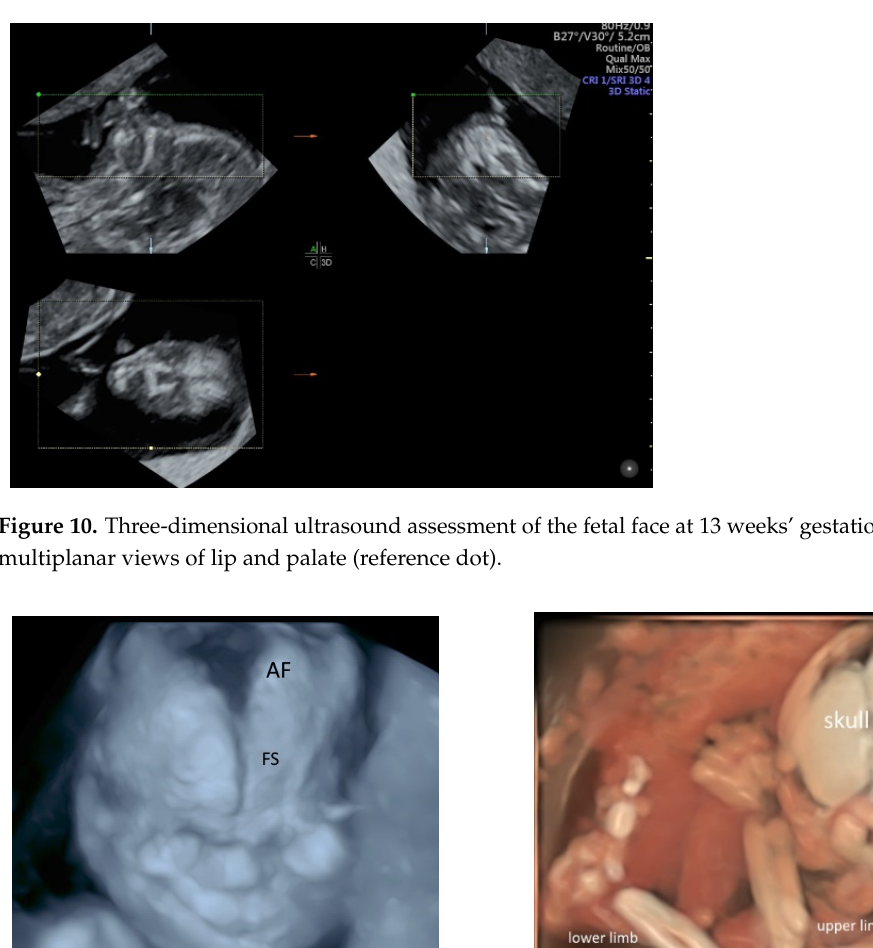
Figure 10. Three-dimensional ultrasound assessment of the fetal face at 13 weeks’ gestation showing multiplanar views of lip and palate (reference dot).